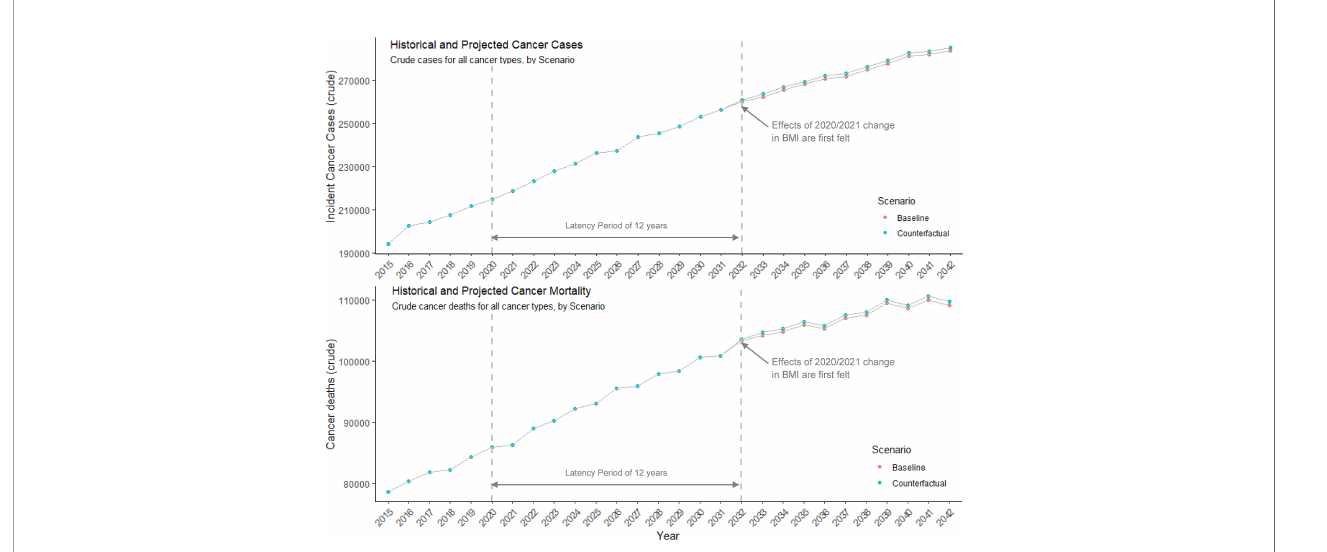
FIGURE 1 | Historical and projected incident cancer cases and deaths for all cancer types. The number of new cancer cases and cancer deaths each year under baseline assumptions of cancer burden trajectories, and a counterfactual scenario where there are anticipated to be excess burdens attributed to pandemic-related